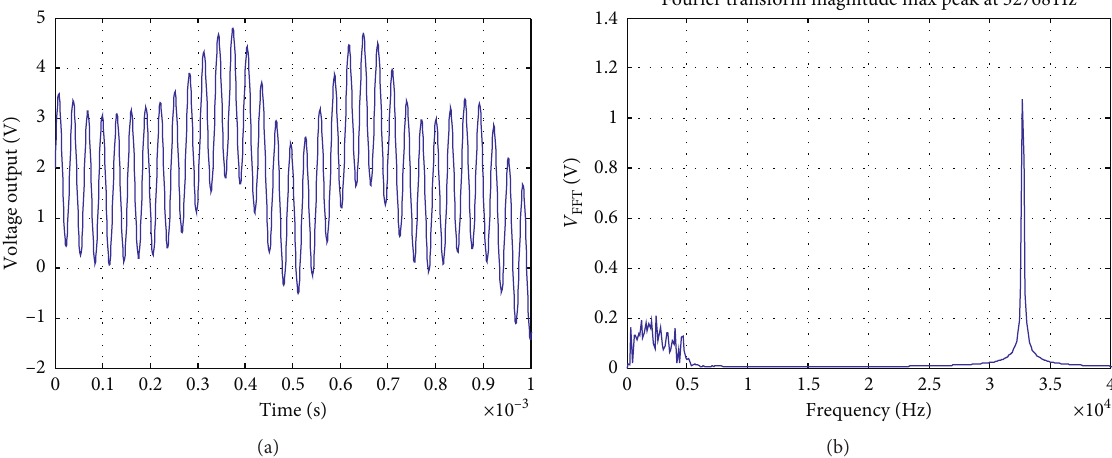
Figure 3: Output signal of the crystal oscillator under external excitation. (a) Signal with noise. (b) Signal in the frequency